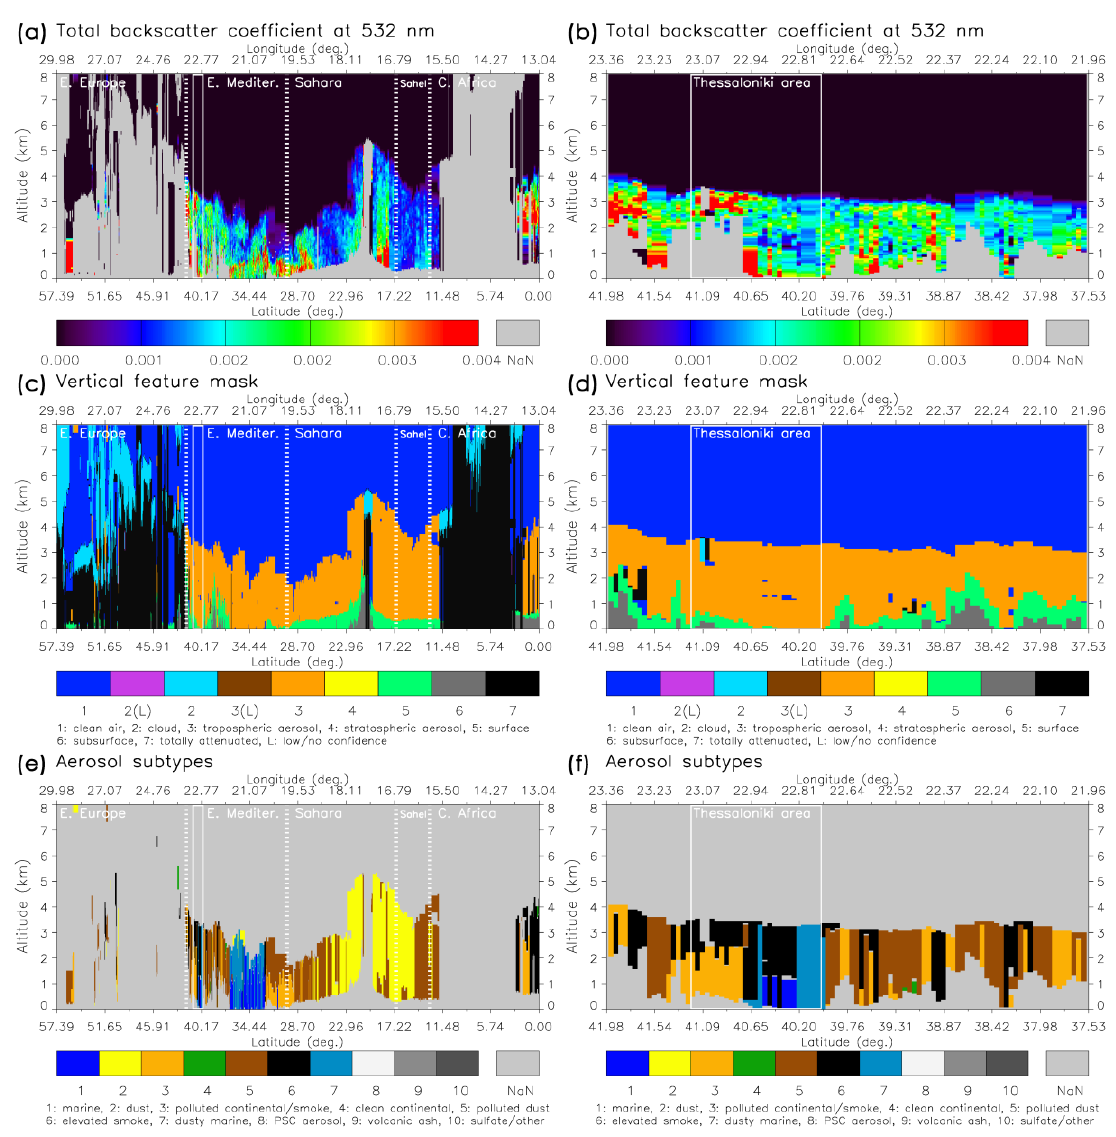
Figure 3. Vertical cross sections of total backscatter coefficient at 532 nm, vertical feature mask and aerosol subtypes over the whole CALIPSO track (a, c, and e) and over the greater Thessaloniki area (b, d, and f). The boundaries of different areas of interest along with that of Thessaloniki are overplotted.